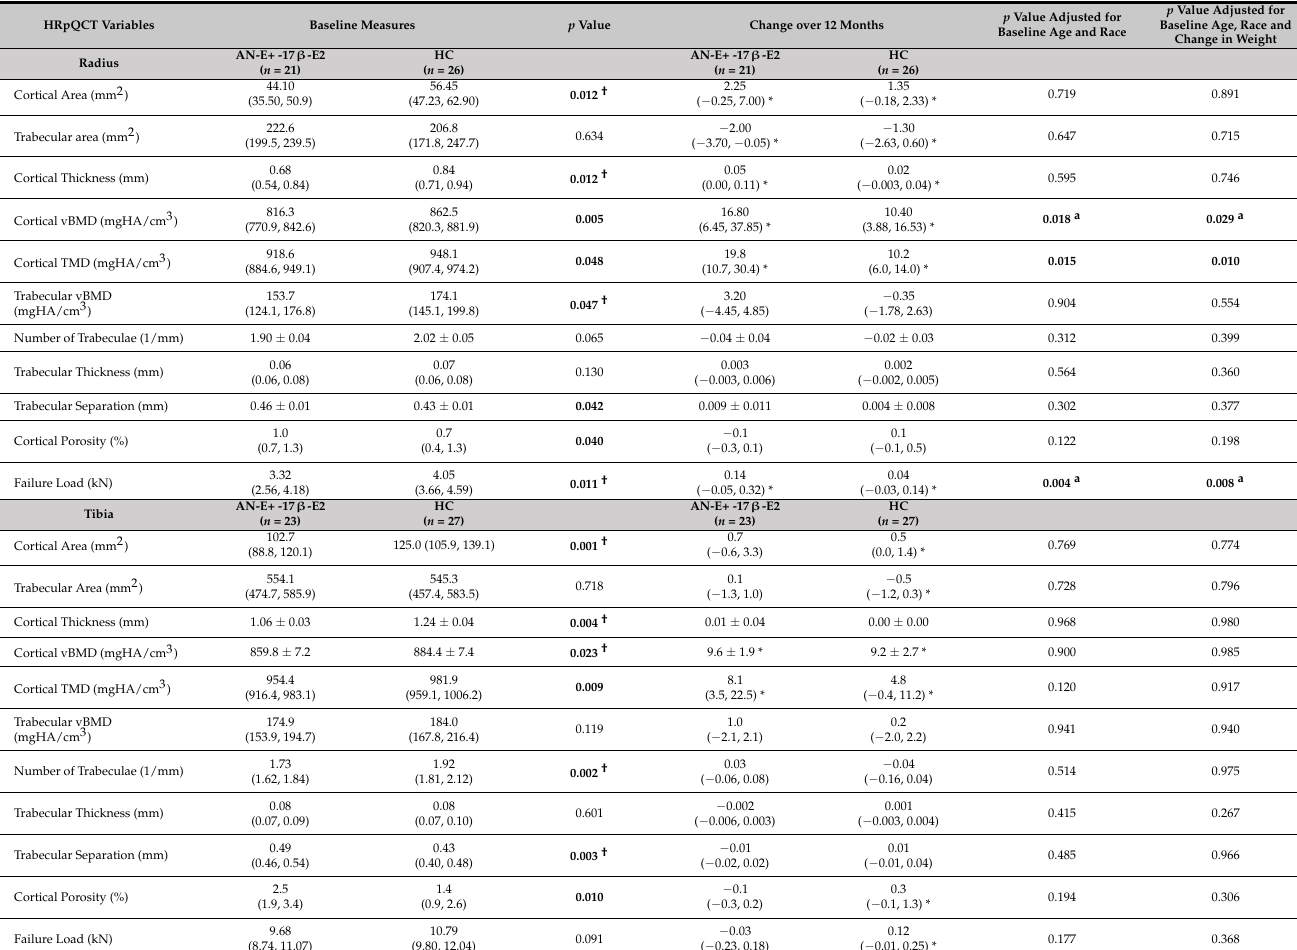
Table 4. Baseline and 12-month change in bone parameters assessed by